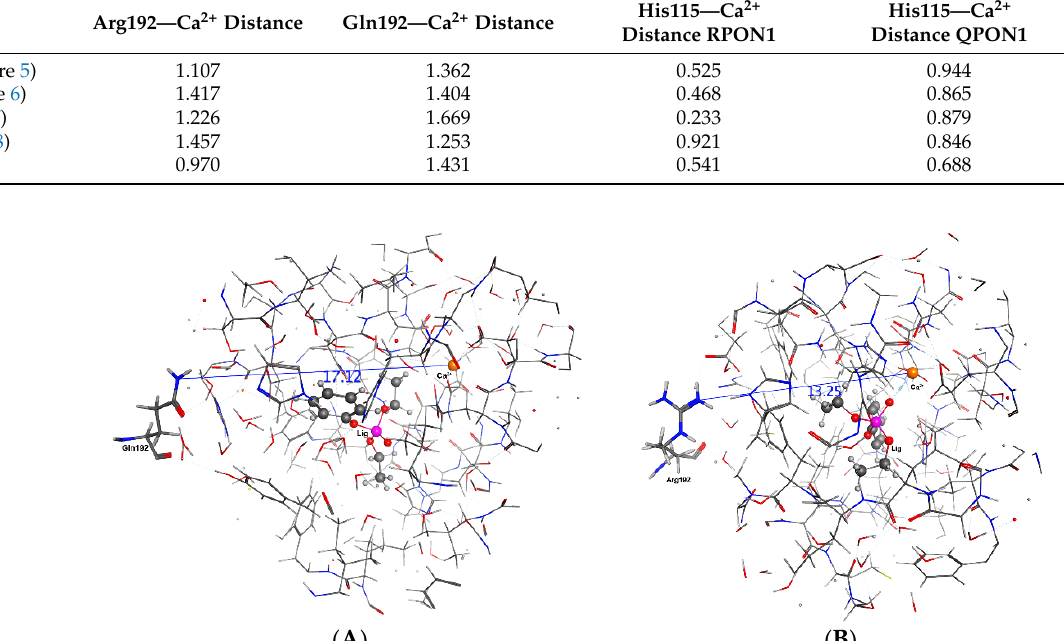
Figure 7. The distance between Glu192/Arg192 and Ca 2+ ion in the active site in the Paraoxon system after 20 ns. ( A ) is the QPON1. ( B ) is the RPON1 .